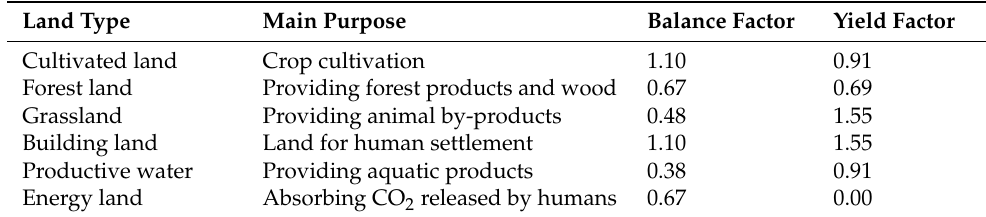
Table 6. Description of the land-cover types and